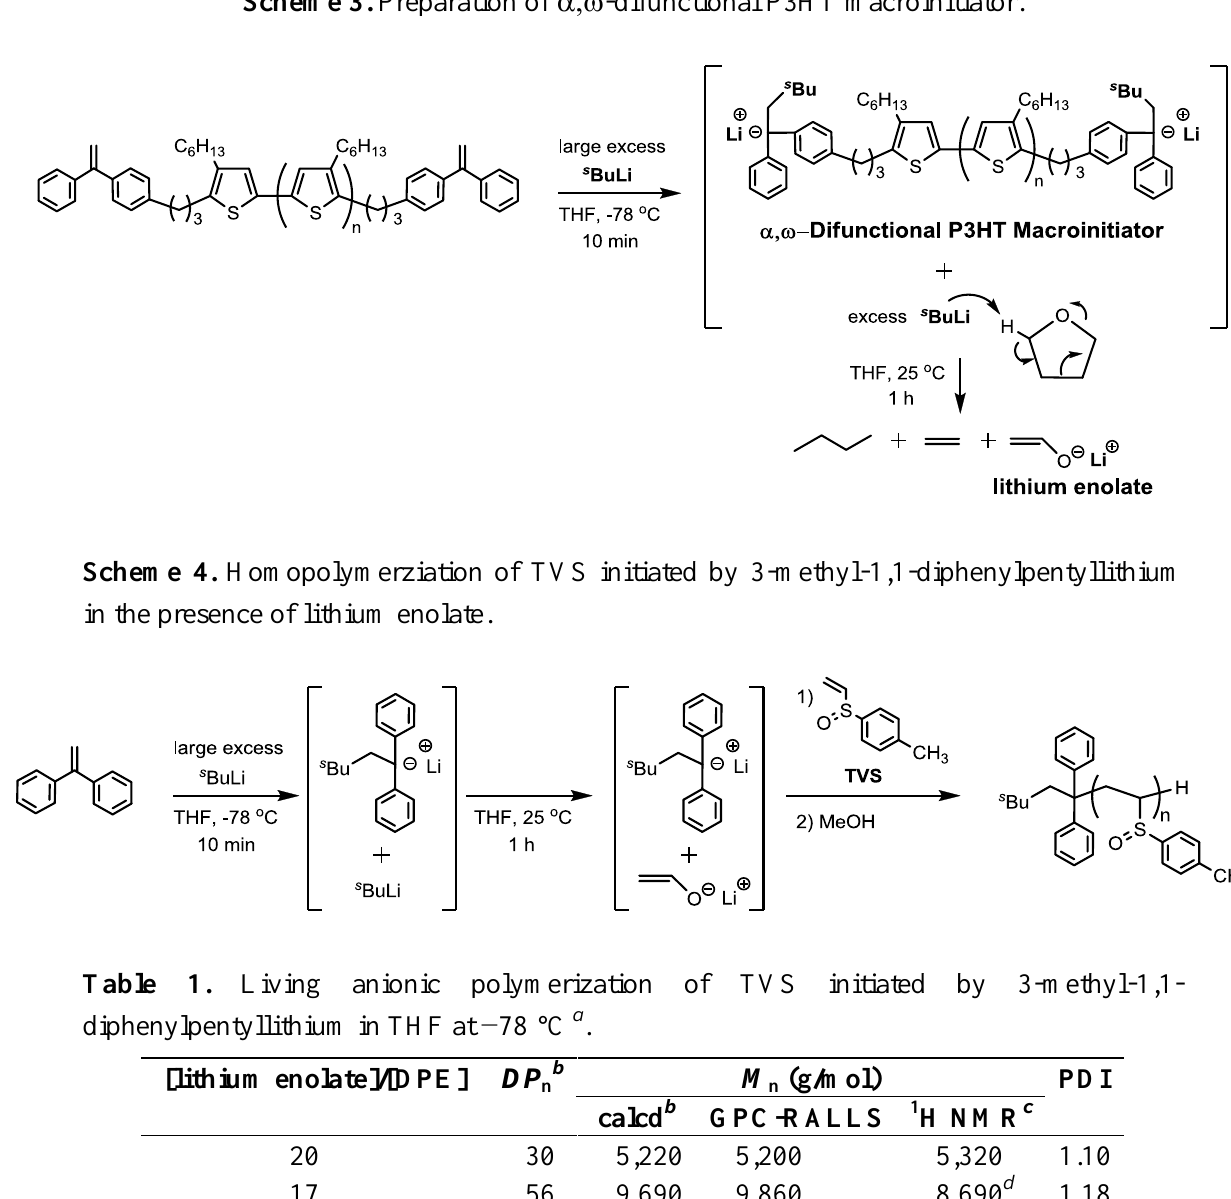
Table 1. Living anionic polymerization of TVS initiated by